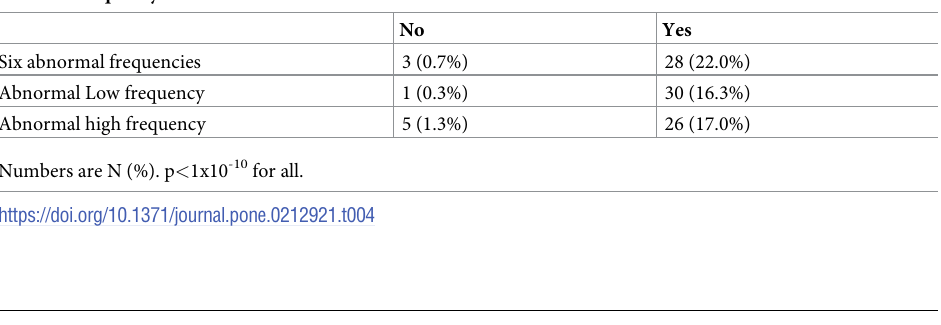
Table 4. Frequency of foot ulcer with different combinations of abnormal